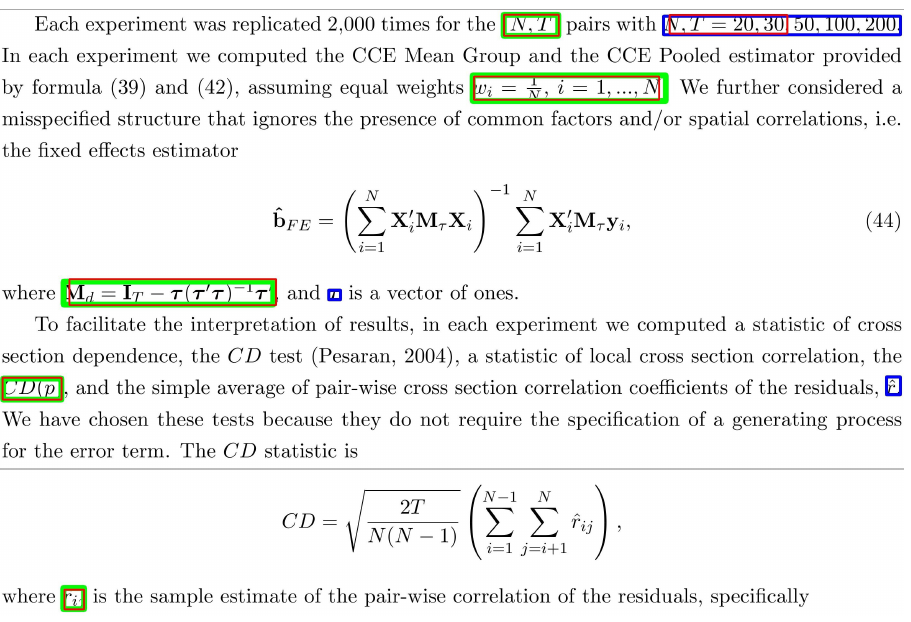
Figure 14. Example of partial and missed detections of embedded formulas in a document image taken from the Marmot dataset. While green color highlights the correct predictions, partial and missed detections are marked with red and blue colors,